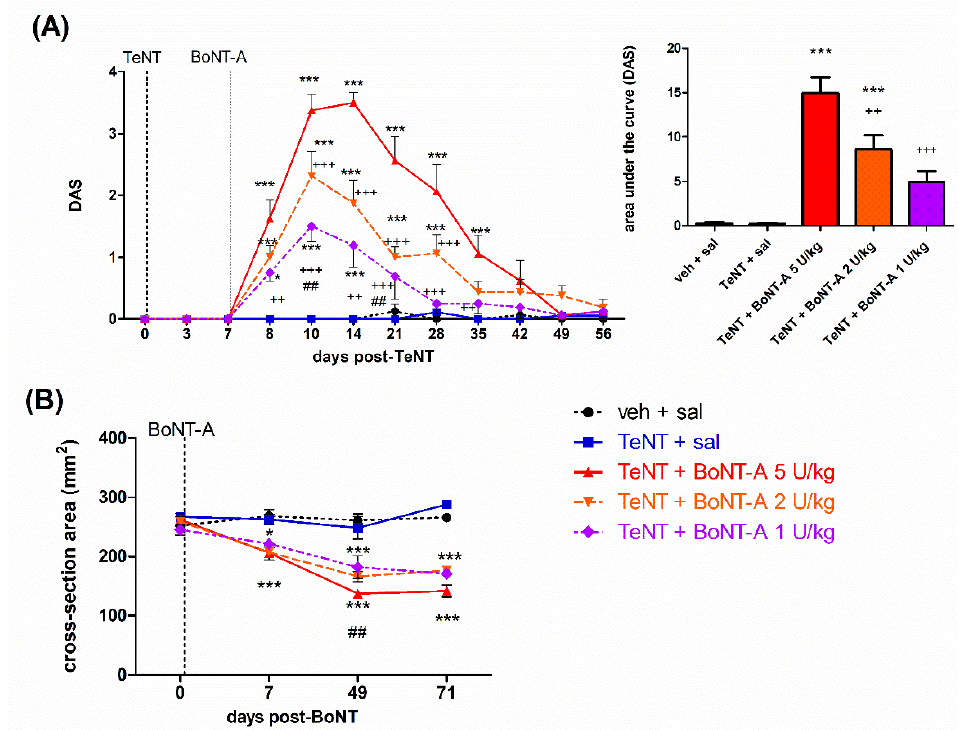
Figure 2. Intramuscular BoNT-A induces reversible impairment of local hind-limb muscle function and non-recovering atrophy in rats. The BoNT-A (1–5 U/kg) intramuscular (i.m.) injections into gastrocnemius induces dose-dependent lasting toe spreading reflex inhibition ( A ), assessed by the digit abduction score (DAS), and atrophic reduction of the lower leg muscles ( B ), represented as the estimated cross-section area of the lower leg at the middle calf muscle level (calculated as the area of ellipse defined by dorsoventral and mediolateral leg diameters). Veh, vehicle; sal, saline i.m. treatment. Horizontal bars indicate the time points of TeNT and BoNT-A i.m. application. N = 8 to 9 animals/group; mean ± SEM, * and ***: p < 0.05 and < 0.001 vs. veh + sal, ++ and +++: p < 0.01 and < 0.001 vs. TeNT + sal; ##: p < 0.01 vs. TeNT + BoNT-A 1 U/kg (two-way RM ANOVA, followed by Bonferroni’s post hoc test; p < 0.05 considered significant).